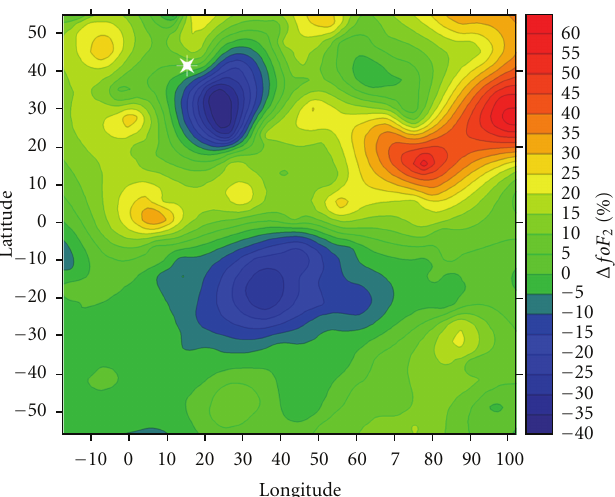
Figure 6: Formation of the conjugated ionospheric anomaly in the southern hemisphere before the Irpinia earthquake on 23 November 1980, M6.9, 64 hours before the main shock during predusk time (3-4LT). White asterisk: the earthquake epicenter position.